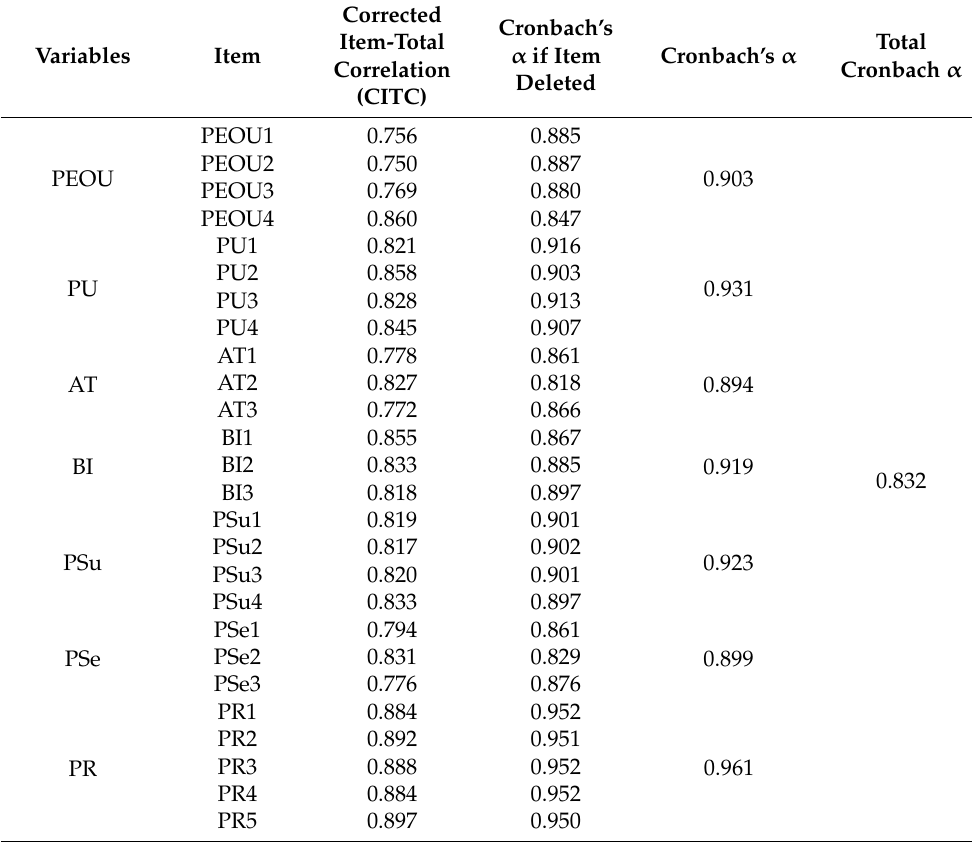
Table 3. Cronbach reliability analysis.